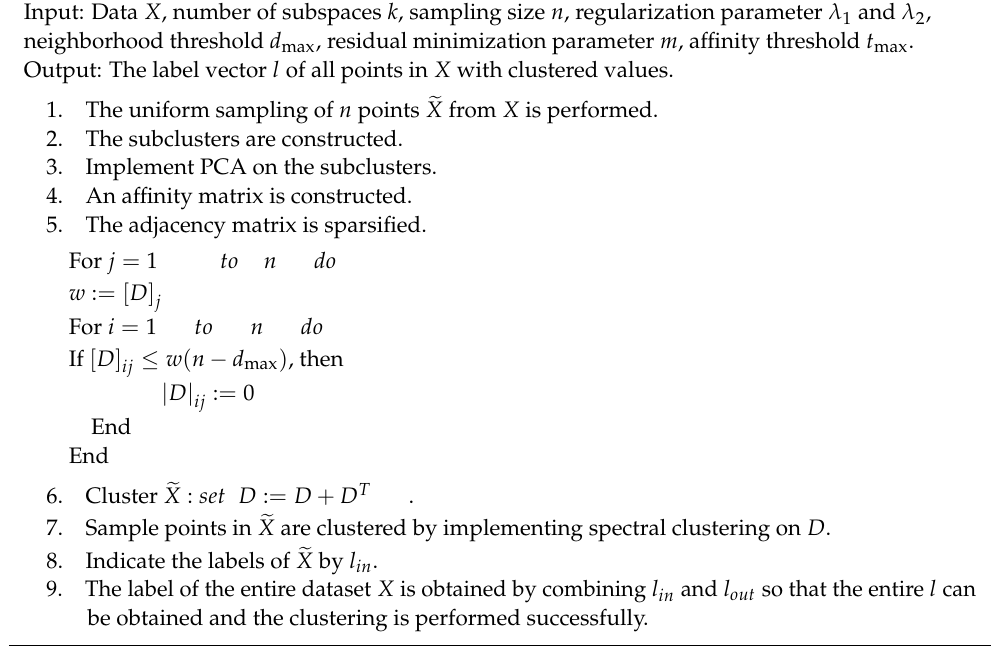
Algorithm 2 : Proposed PCA-based subspace